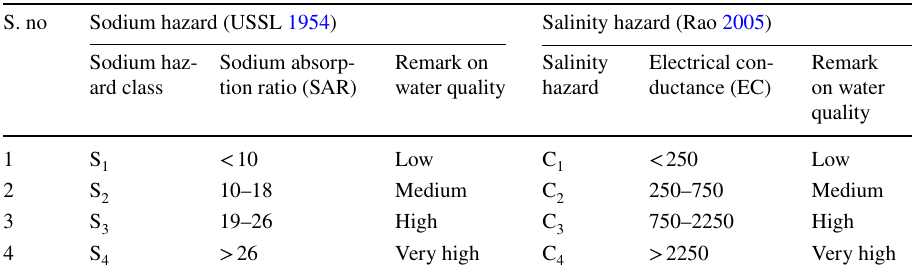
sodium hazard based on SAR and salinity hazard based on EC